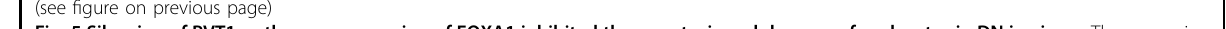
Fig. 5 Silencing of PVT1 or the overexpression of FOXA1 inhibited the apoptosis and damage of podocytes in DN in vivo. a The expression of PVT1 and FOXA1 in mice with DN in vivo. b FOXA1 promoter recruitment in vivo detected by ChIP assay, n = 10. c The degree of glomerulosclerosis and renal tubule atrophy in response to the treatment of sh-PVT1 and/or GSK126 assessed by periodic acid-Schiff (PAS) staining (the original magni fi cation is ×400). d Podocyte apoptosis in response to the treatment of sh-PVT1 and/or GSK126 in vivo. e Immuno fl uorescence staining displaying the expression of podocyte marker Nephrin and FOXA1 in vivo (the original magni fi cation is ×400). f The protein level of FOXA1 in vivo detected by western blot analysis; * p < 0.05 vs. the sh-NC group. The measurement data are expressed as the mean ± standard deviation, and the comparisons among multiple groups were analyzed by one-way analysis of variance (ANOVA). The experiment was repeated three times. DN, diabetic nephropathy; PVT1, plasmacytoma variant translocation 1; IgG, immunoglobulin G; FOXA1, forkhead box A1; NC, negative control; DAPI, 4 ′ ,6- diamidino-2-phenylindole; GAPDH, glyceraldehyde-3-phosphate dehydrogenase; GSK126, EZH2